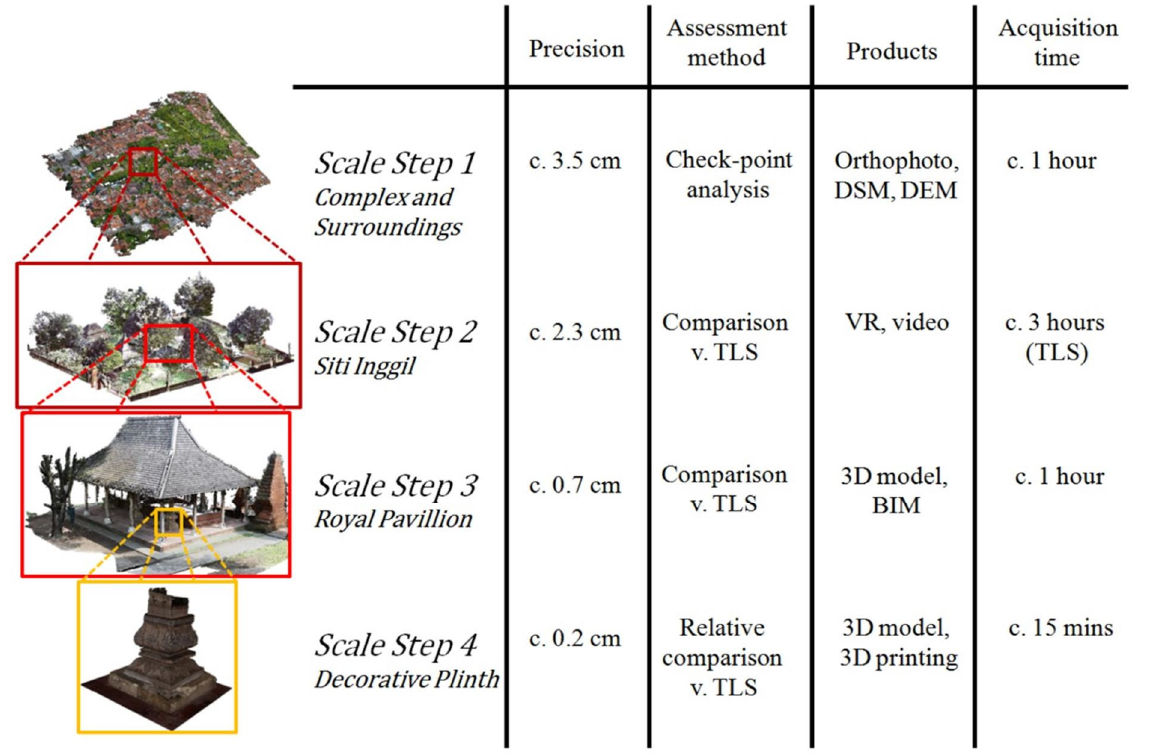
Figure 9. Example of the result of the multi-scale approach. In step 1, the whole Kasepuhan complex and its surroundings are modeled by aerial photogrammetry. Step 2 shows the Siti Inggil area within the palace compounds; here is shown the registered TLS point cloud. Step 3 shows a building, the Royal Pavilion, within Siti Inggil, which was modeled using close-range photogrammetry. Finally, step 4 shows an architectural detail, in this case a column’s plinth, also modeled using close-range photogrammetry. Reprinted from Ref. [129] with permission of the ISPRS International Journal of Geo-Information, 2018.